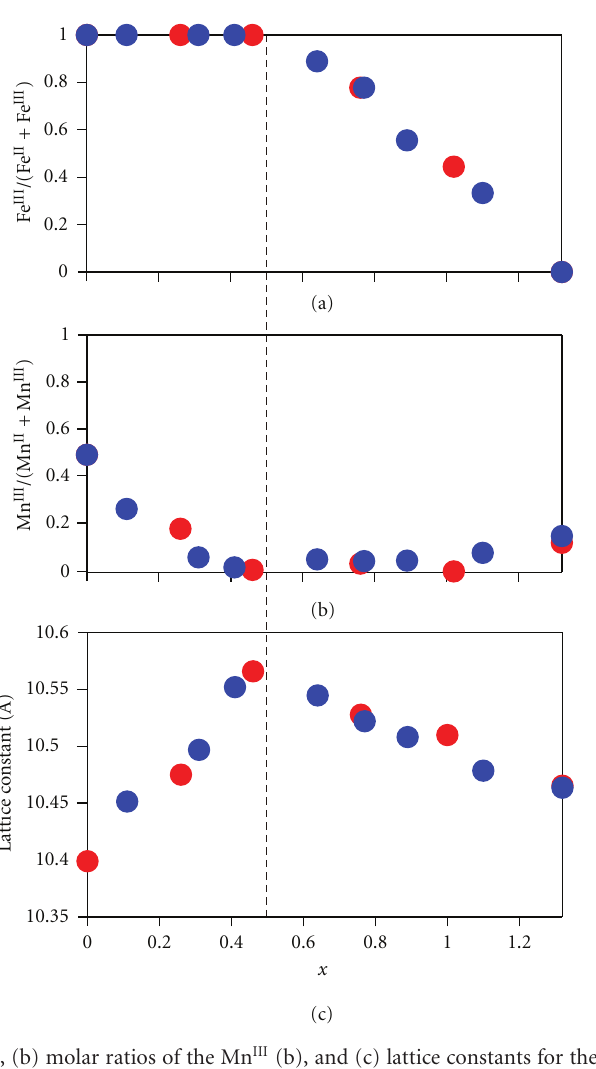
· 3 . 5H ] 2 O. 6 0 . 83